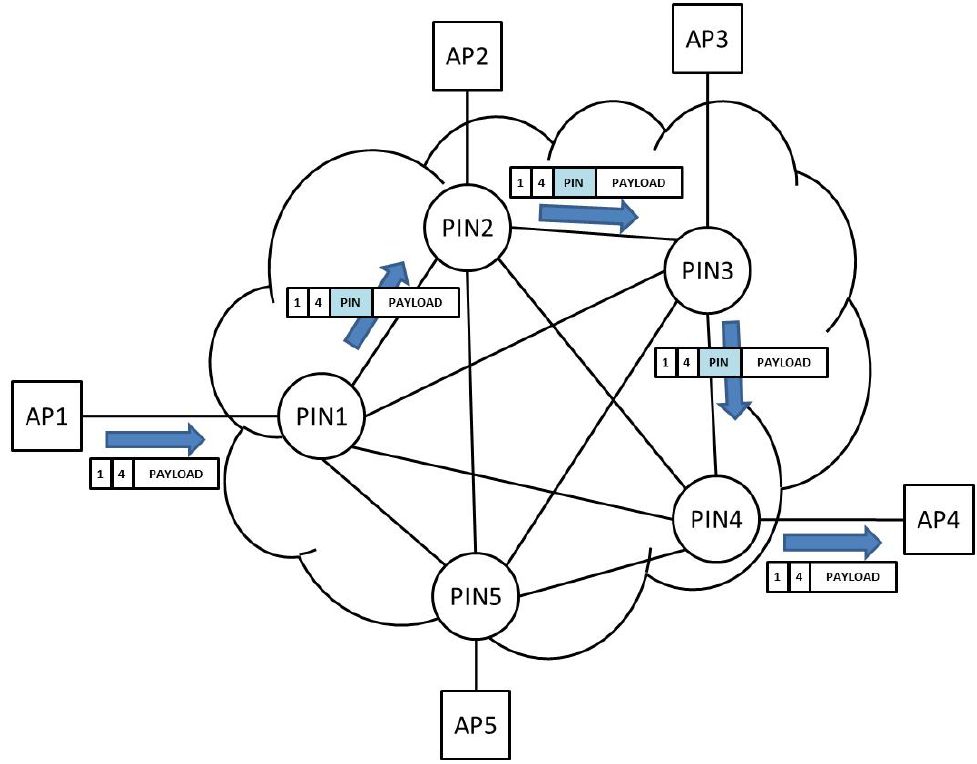
Figure 12. Software prototype test